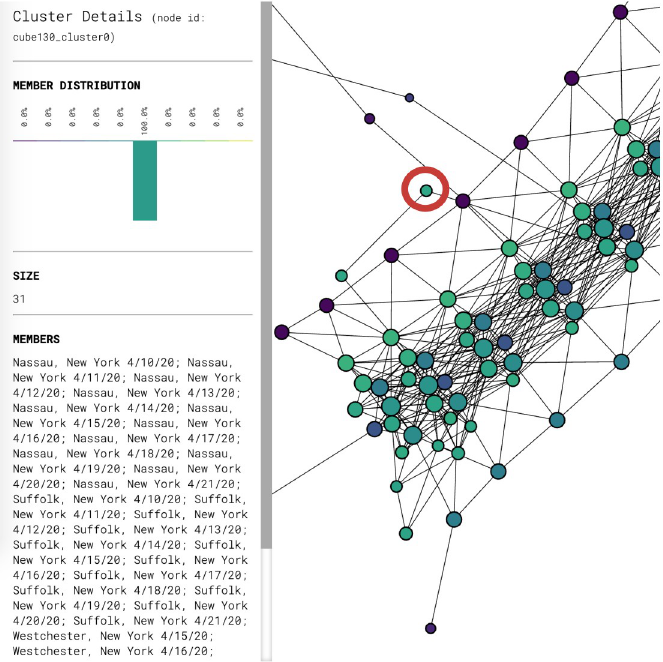
Fig 4. Breakdown of the data inside the node circled in red. The node contains 31 data points, all of which come from New York State.